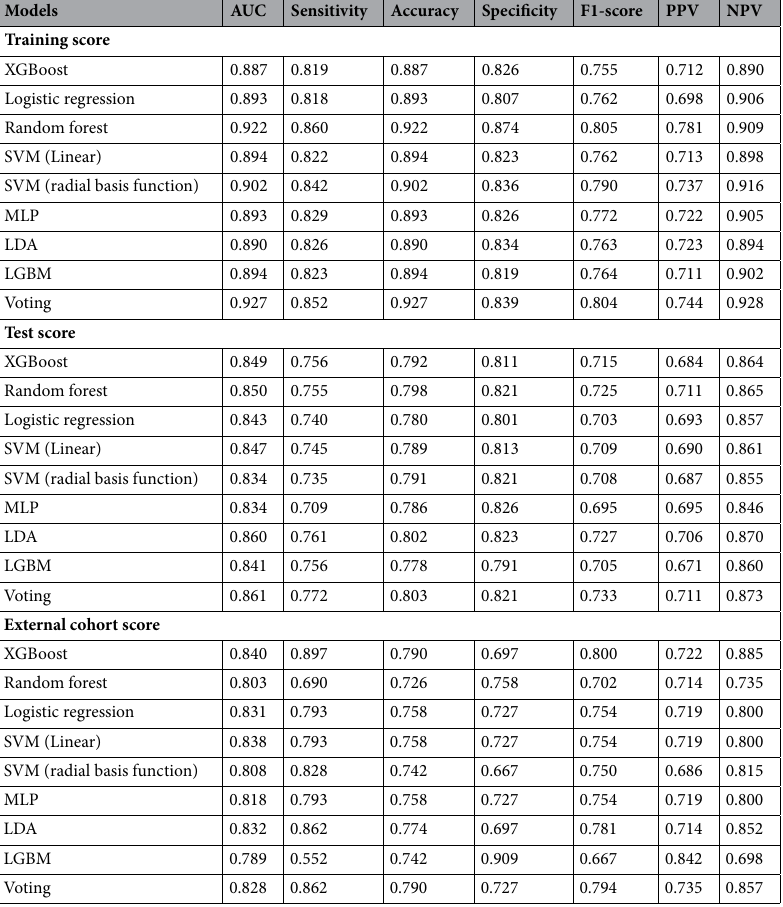
Table 2. Prehospital diagnostic algorithms for acute coronary syndrome using 43 features. AUC (area under the receiver operating characteristic curve), LDA (linear discriminant analysis), LGBM (light gradient boosting